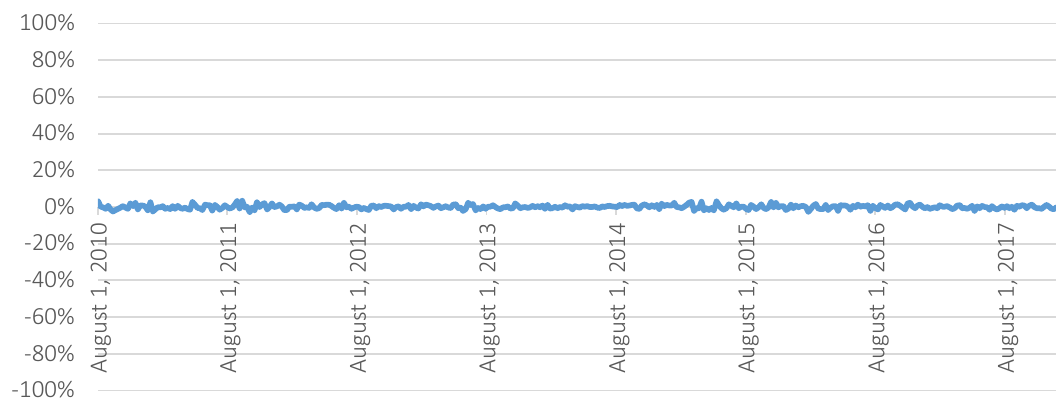
Figure 3. Returns for the USD 2010–2018